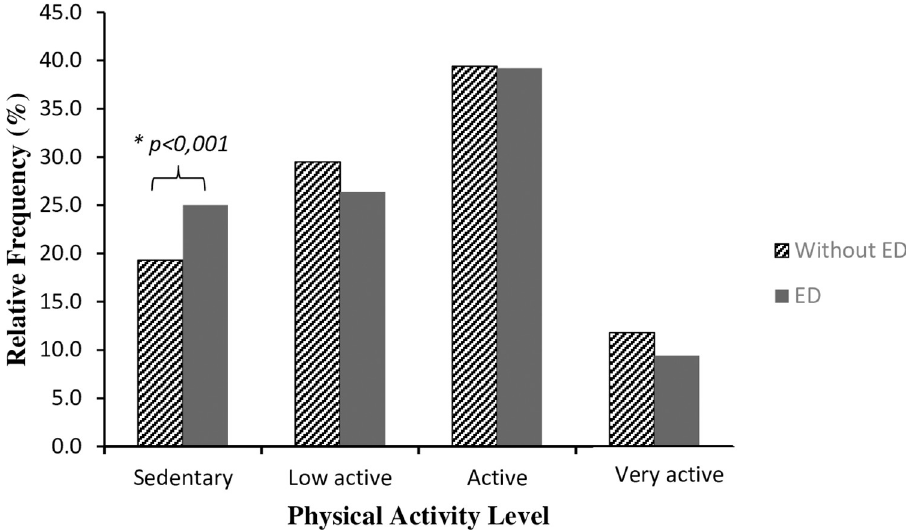
Fig 1. Level of physical activity among men with and without erectile dysfunction (n = 20,789).